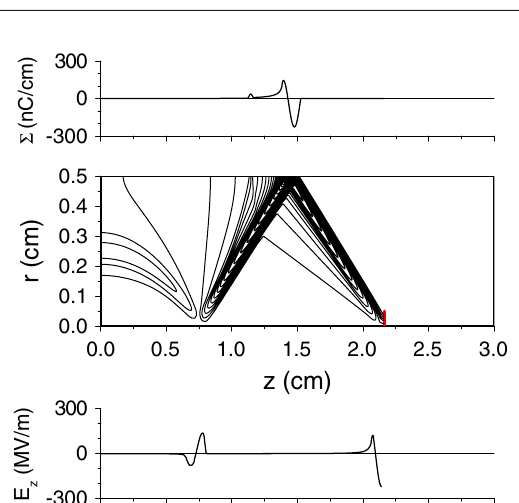
FIG. 4. Flux lines, axial electric field on the beam axis ( E and the lineal surface charge density ( (cid:4) ) of a wakefield in a semi-infinite waveguide filled with a